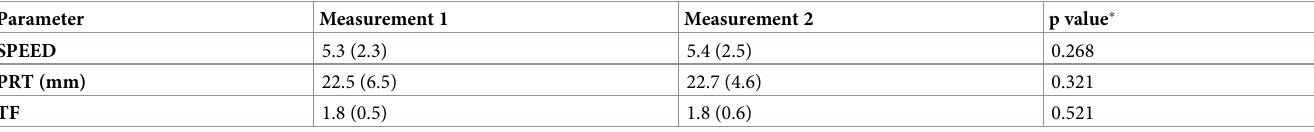
Table 2. The median (IQR) for the SPEED, PRT, and TF scores in the control group (n = 25).